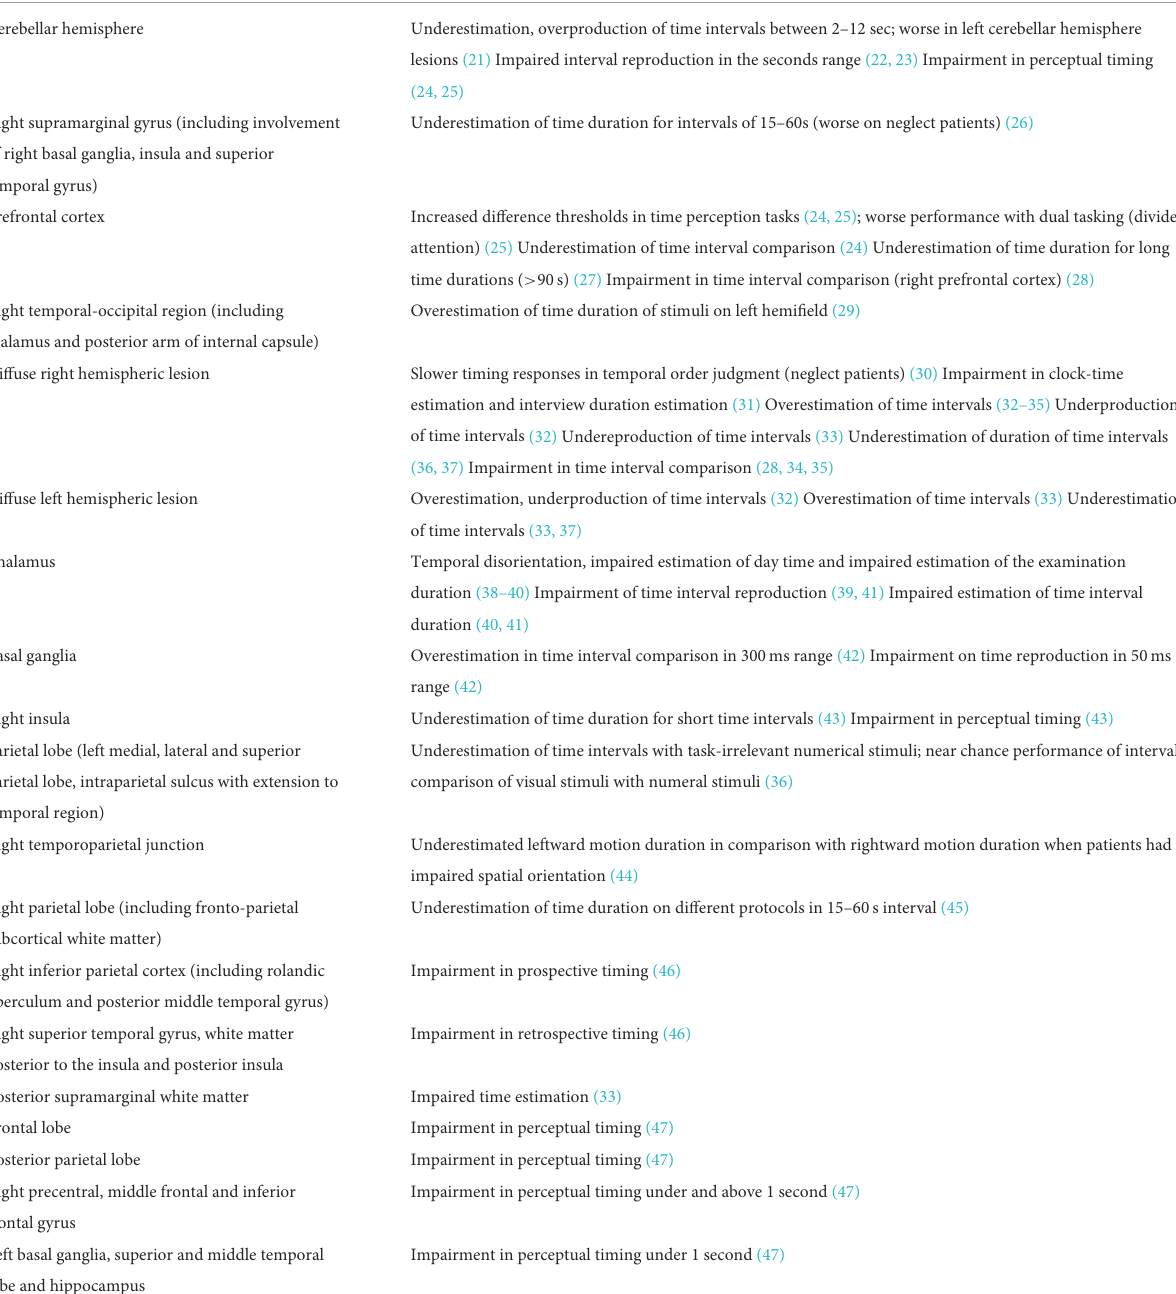
TABLE 3 Lesion topography and respective associated time perception deficits. Lesion